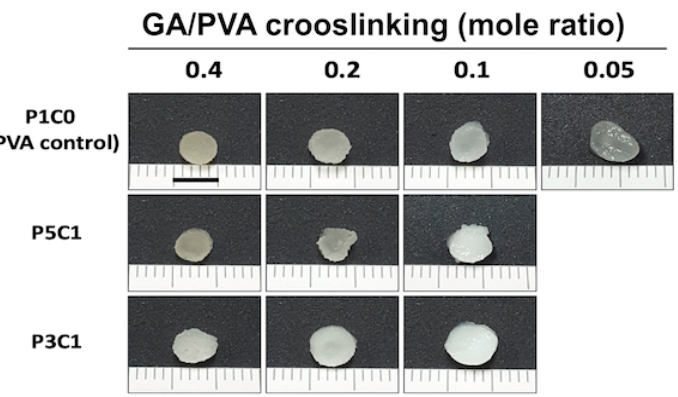
Figure 1. Appearance of PVA/CMC porous scaffolds. P1C0 is PVA/CMC = 1:0; P5C1 is PVA/CMC = 5:1; P3C1 is PVA/CMC = 3:1. The scale bar is 0.5 cm.